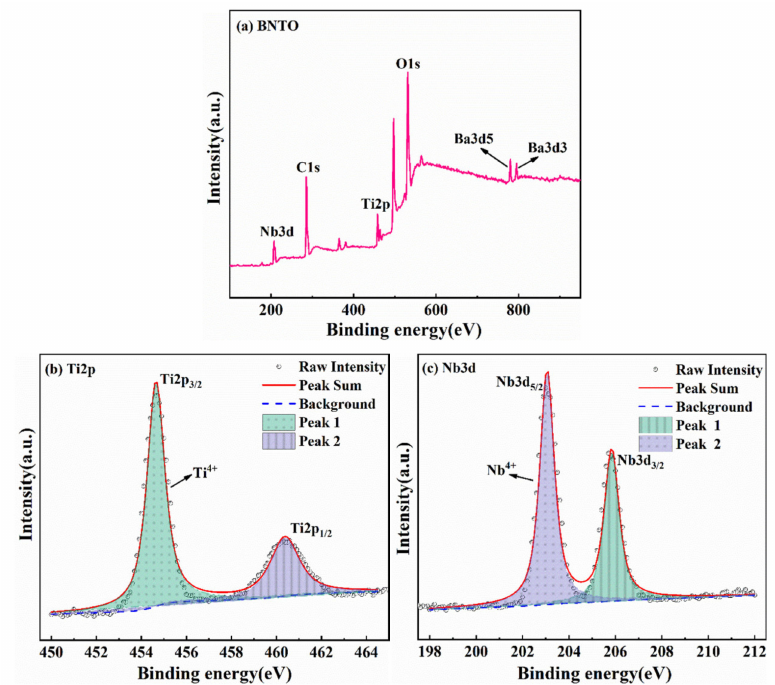
Figure 3. XPS spectra of electrochemically synthesized BNTO nanoparticles: ( a ) the XPS full spectrum of the sample, ( b ) the Ti2p fine spectrum, and ( c ) the Nb3d fine